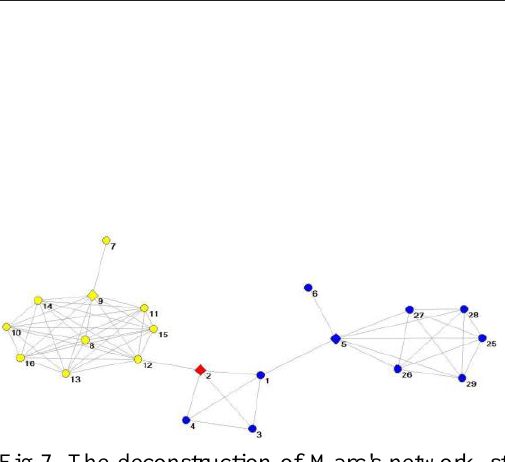
Fig. 6. A chain of recalculated intermediaries after the removal of the most central one.